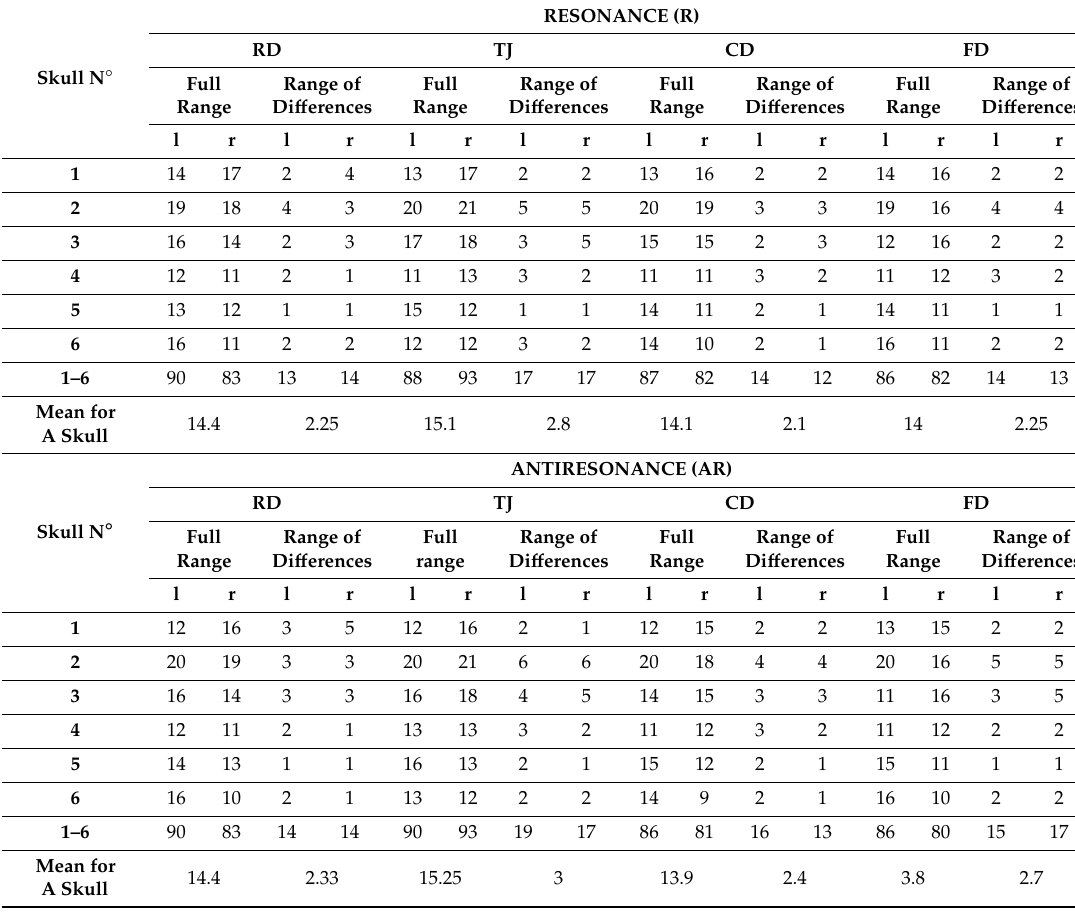
Table 3. The number of Rs and ARs in each state of dentition and percentage of Rs and ARs with RD for TJ, CD, and FD. Full ranges and the “ranges of di ff erences”